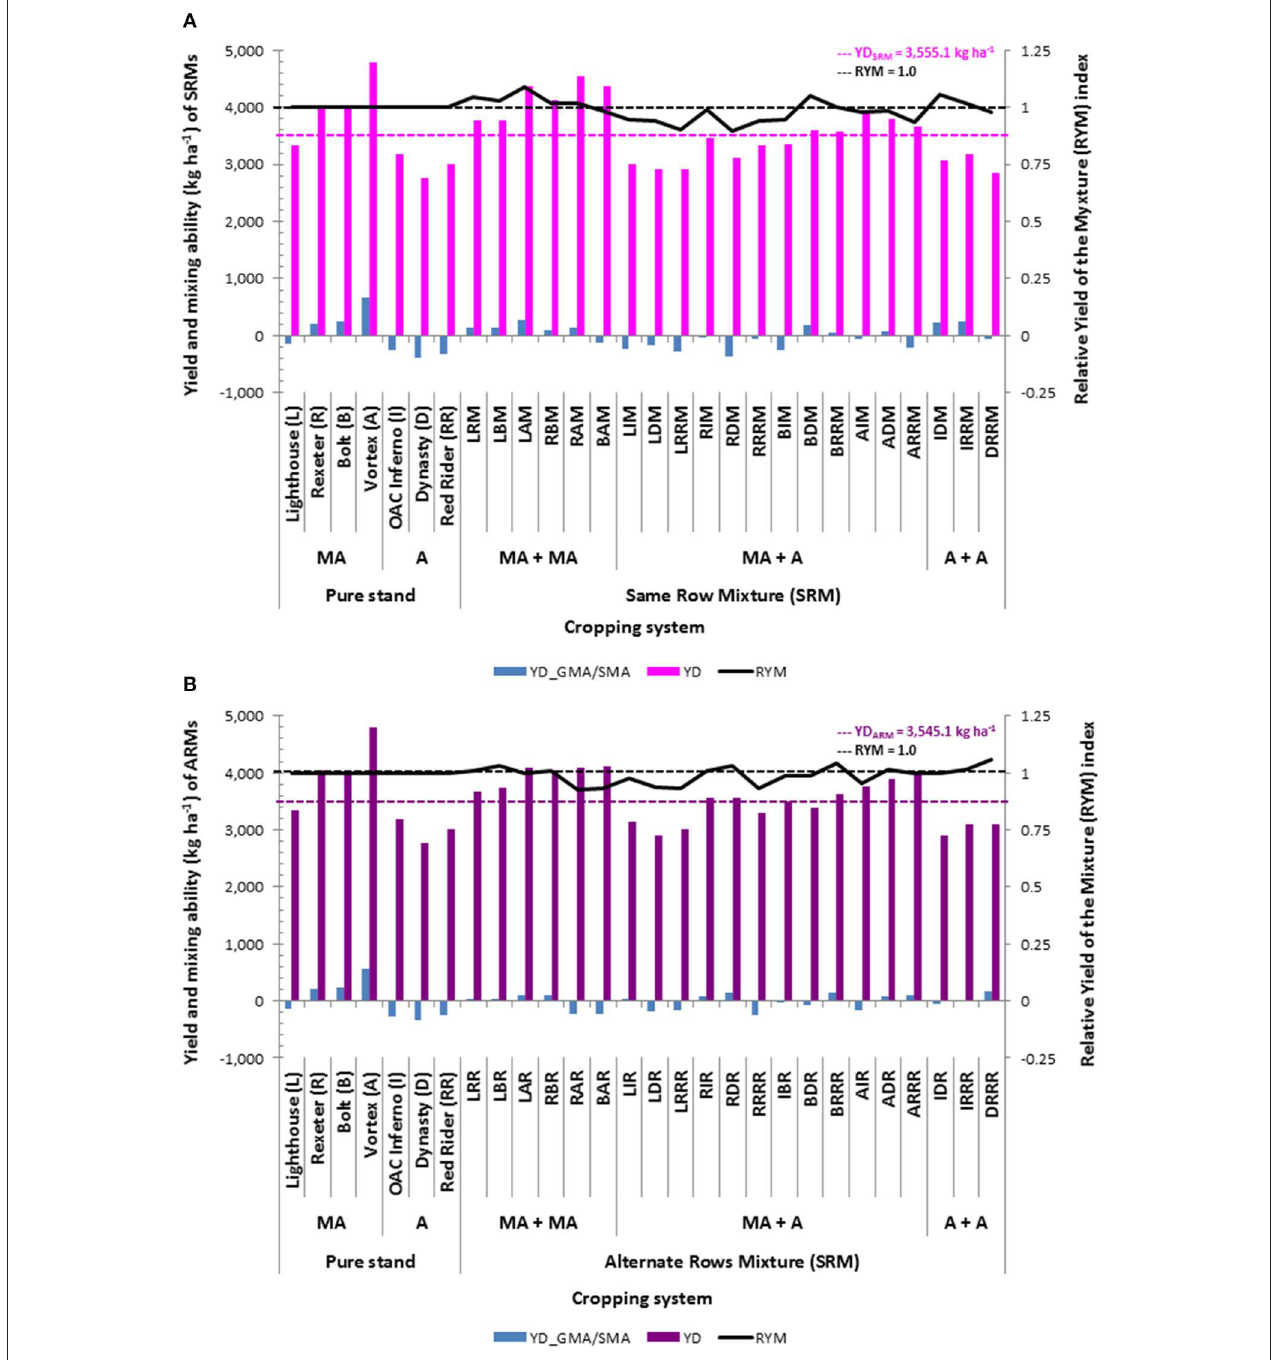
FIGURE 9 | Selection of the best mixture of common bean cultivars based on the yield, relative yield of the mixture (RYM) index and mixing ability. (A) Same row mixtures (SRM); (B) Alternate rows mixtures (ARM).